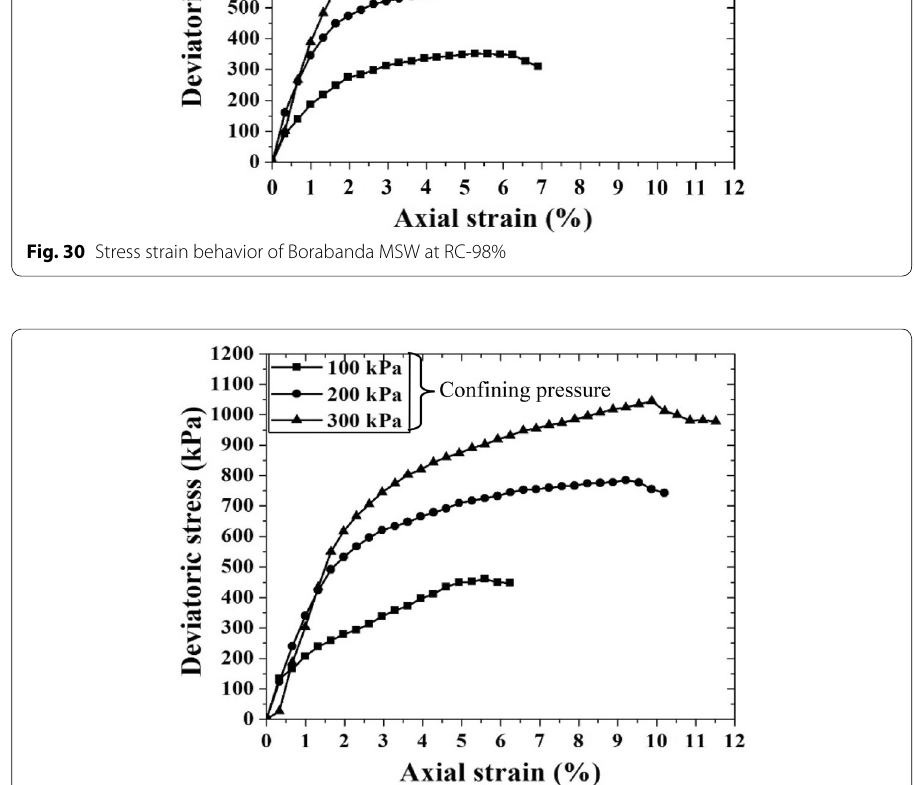
Fig. 31 Stress strain behavior of Borabanda MSW at